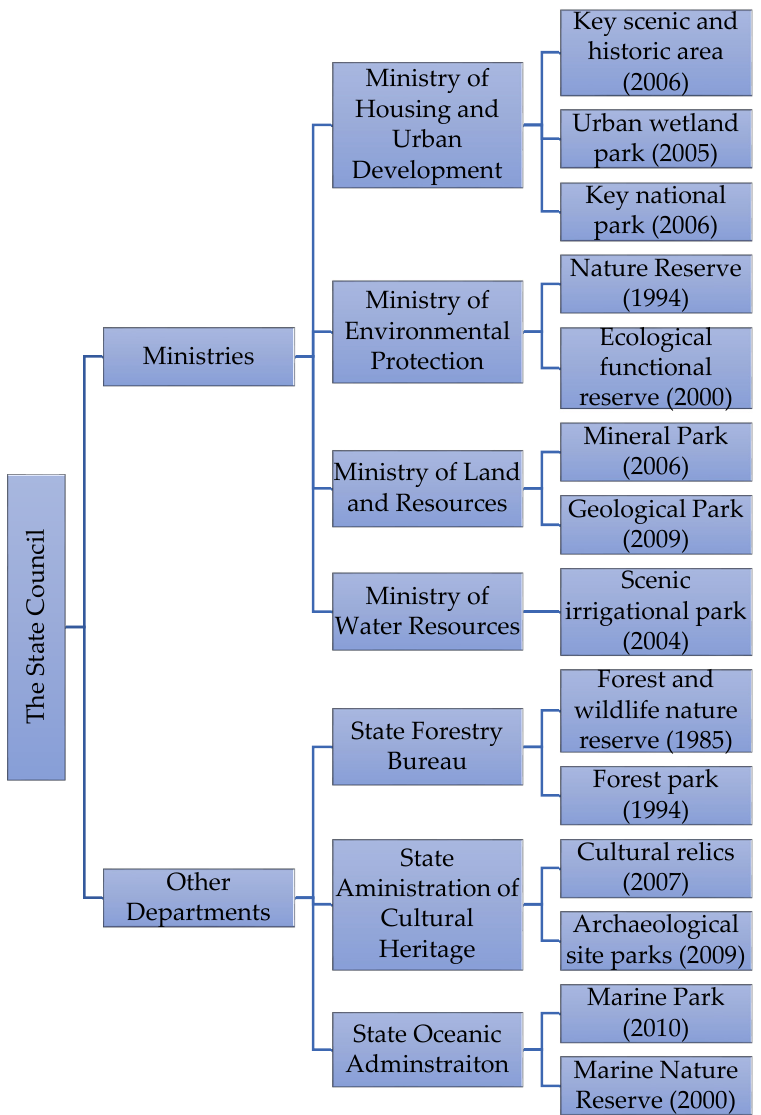
Figure 3. The conventional protected area (CPA) institution structure in China before 2018 (adapted from [40,41]).